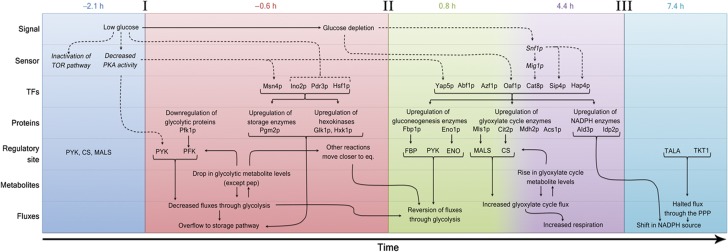
Time-course reconstruction of the different events that lead to the adaptation based on the results presented in this report (regular text and solid arrows) and also supported by studies that were previously published (italics and dashed arrows) (Boy-Marcotte et al, 1996, 1998; DeRisi et al, 1997; Vincent and Carlson, 1998; Haurie et al, 2001; Haurie et al, 2004; Brauer et al, 2005; Radonjic et al, 2005; Slattery et al, 2008).